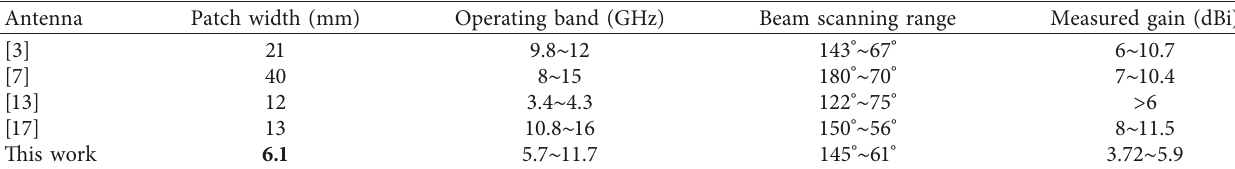
Figure 11: The reflection coefficient and measured gain against frequency of the proposed periodic Table 2: Comparison between parameters/characteristics.